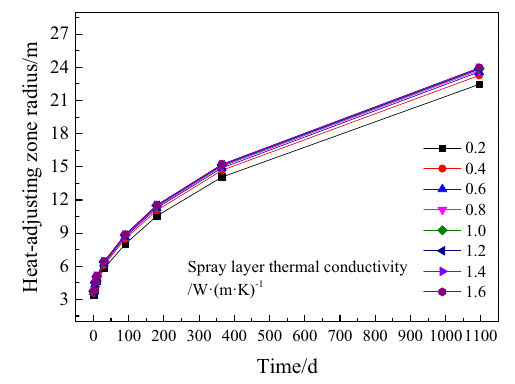
Figure 15: Influence of spray layer thermal conductivity on heat - adjusting zone